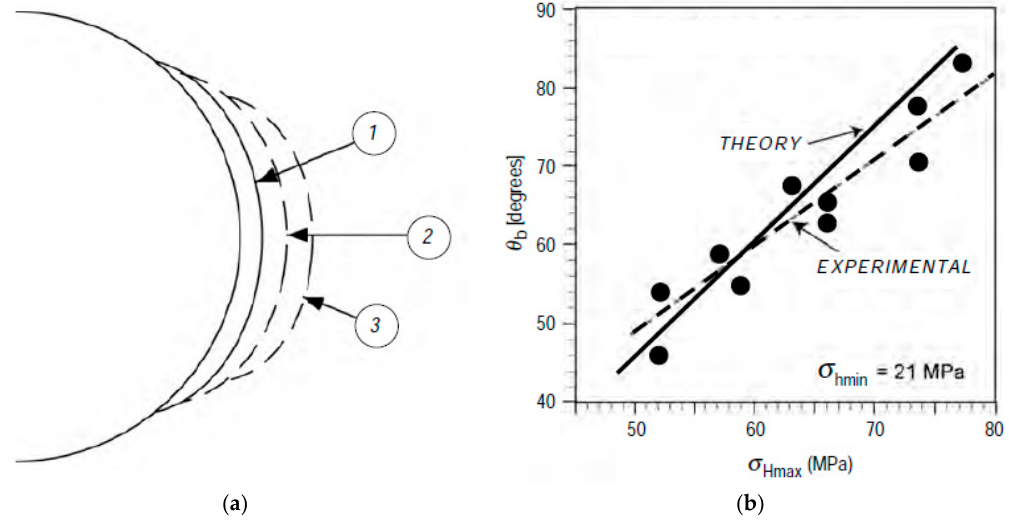
Figure 5. Schematic representation of breakout growth (Reproduced from [6]). ( a ) The theoretical model after the formation of wellbore breakouts, wellbore breakouts deepen but do not widen; ( b ) The measured breakout widths compared very well with those predicted by the simple theory.